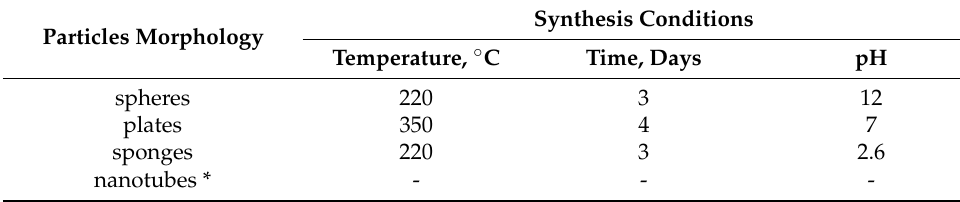
Table 1. Samples morphology and synthesis